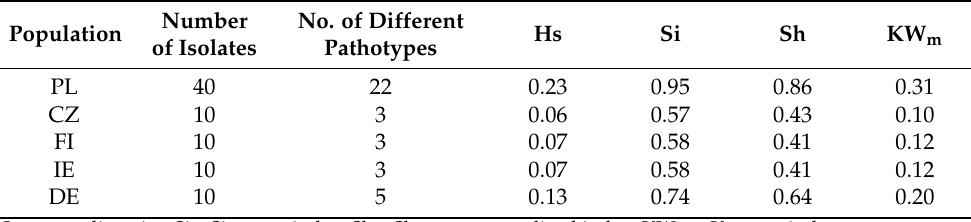
Table 2. Diversity parameters of the analysed B. graminis f. sp. avenae populations. Population